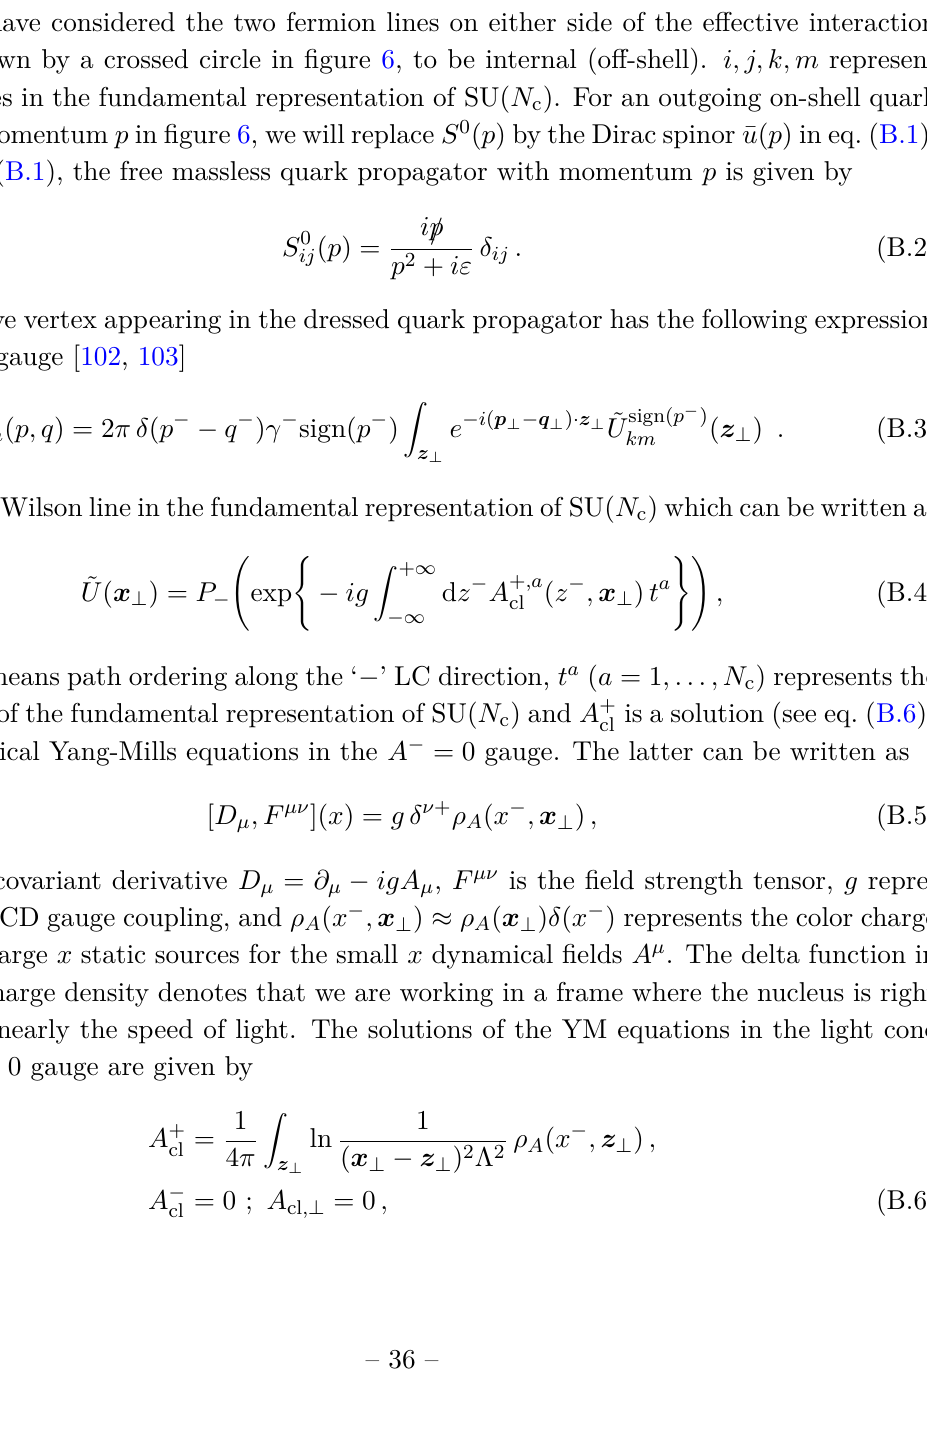
Figure 6 . Feynman diagram for the dressed quark propagator in the classical background field of the nucleus. i and j denote the color indices in the fundamental representation of SU( N c )